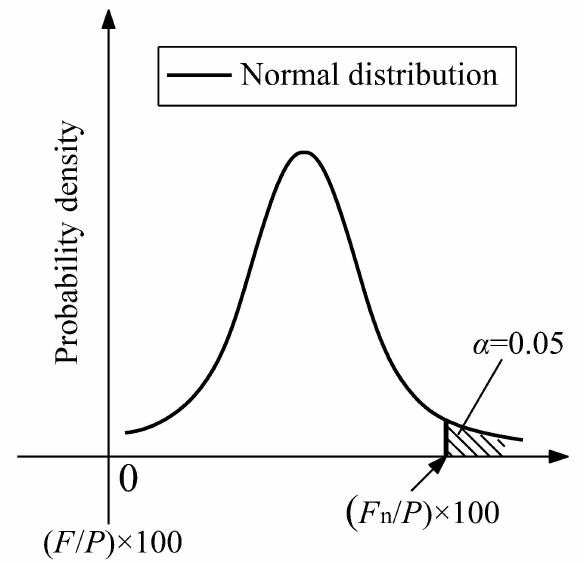
Figure 7. The characteristic values at α =